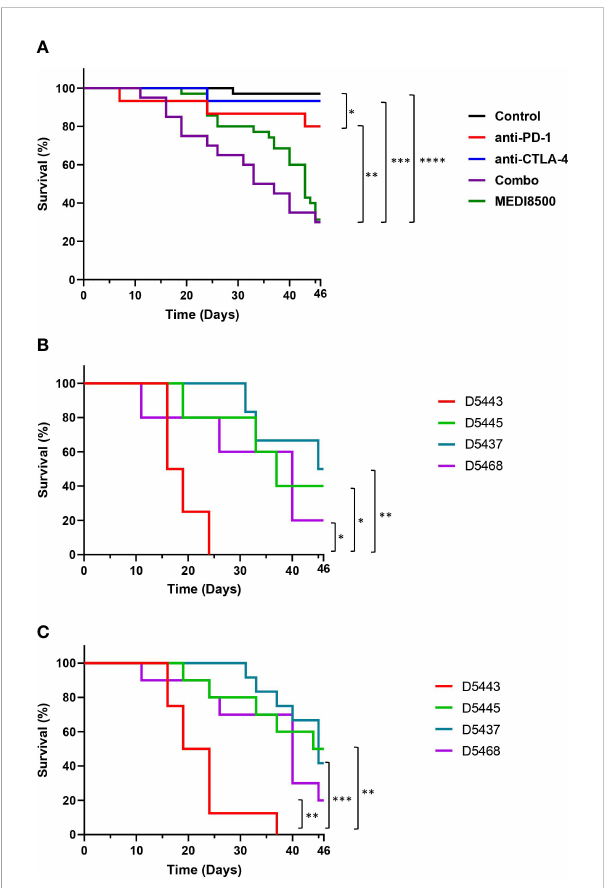
FIGURE 2 Acceleration of GvHD with antibody combination and MEDI8500 compared to monotherapies (A) Kaplan-Meier plot showing overall survival in the different groups of treatment. The control (n=35) and MEDI8500 (n=35) groups include data from two independent experiments, while the data for the anti-PD-1 (n=15), anti-CTLA-4 (n=15) and antibody combination (n=20) groups are from a single experiment. (B) Survival curves in the antibody combination group depending on the HLA type of the donor. Each donor showed was used to reconstitute 4-6 mice per treatment group. (C) Survival curves in MEDI8500 group depending on the HLA type of the donor. Each donor showed was used to reconstitute 4-6 mice per treatment group. The Mantel-cox test was used to assess statistical differences between groups; * P < 0.05, ** P < 0.01, *** P < 0.001, **** P <